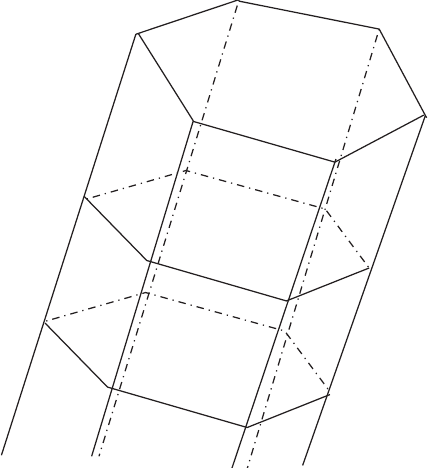
Figure 2: The 3D expression of TUC 4 [6,𝑛] .